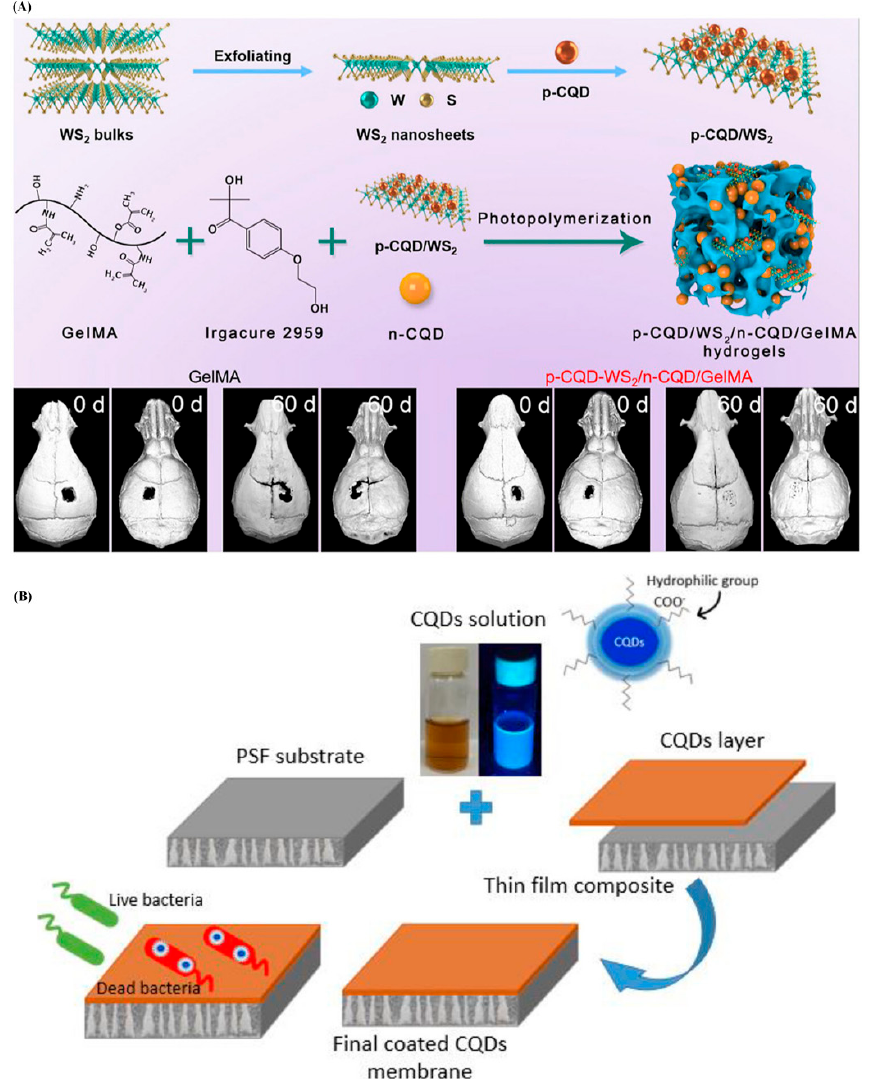
Figure 6. ( A ) Schematic representation of the synthesis of a p-CQD/WS 2 /n-CQD/GelMA hydrogel for regeneration of bone defects. Micro computed tomography (micro-CT) images of calvarial defects treated with GelMA and p-CQD/WS 2 /n-CQD/GelMA hydrogels for 0 or 60 days were presented. Reproduced with permission from [47]. Copyright 2021, Elsevier Ltd. ( B ) Scheme showing the fabrication of a CQDs-coated PSF membrane for realizing the antibacterial action in the process of forward osmosis. Reproduced with permission from [105]. Copyright 2020, Elsevier B.V.